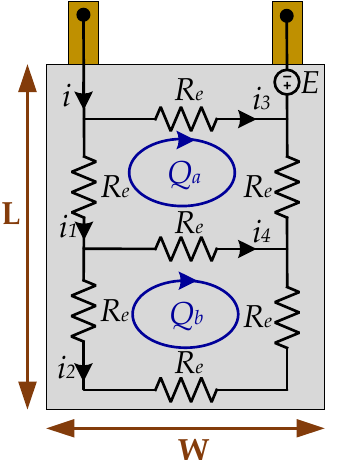
Figure 2. Electrical model.